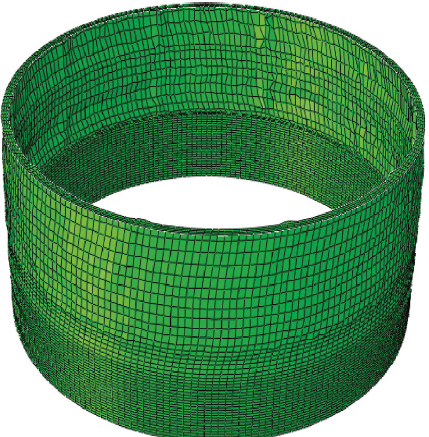
Figure 14: Forming model of